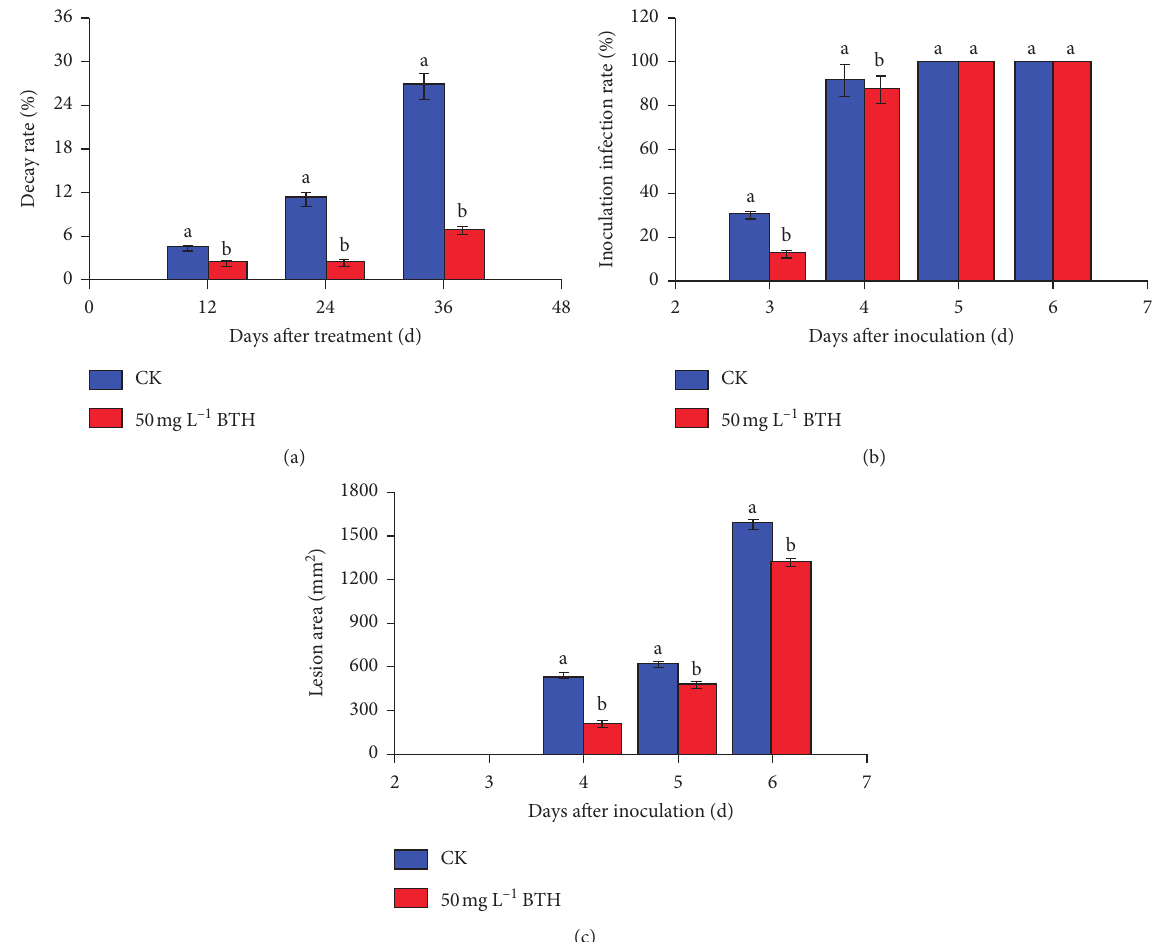
Figure 1: Effects of BTH on the decay rate during storage and disease incidence and lesion area of navel orange fruits challenged with P. italicum at 20 °